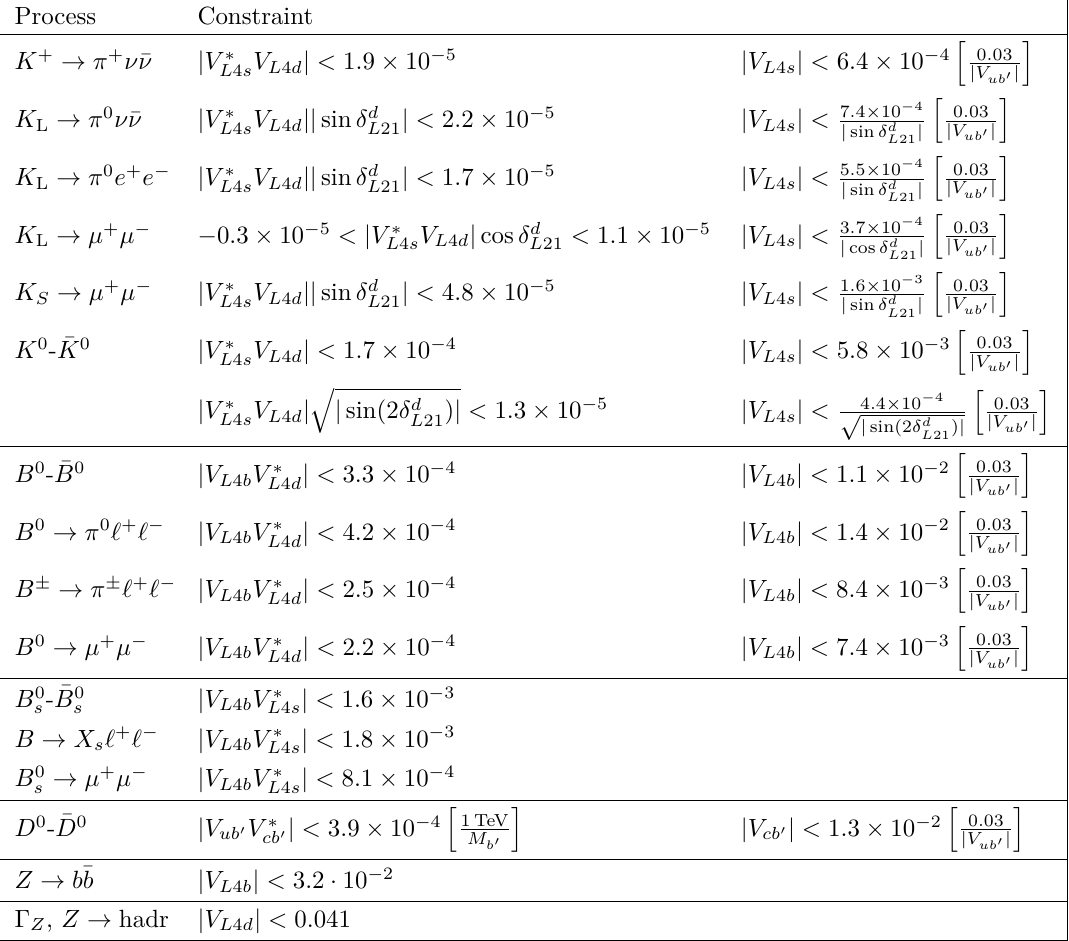
− δ d ) = δ d . Regarding the elements of CKM matrix, V ub 0 Li Lj Lij